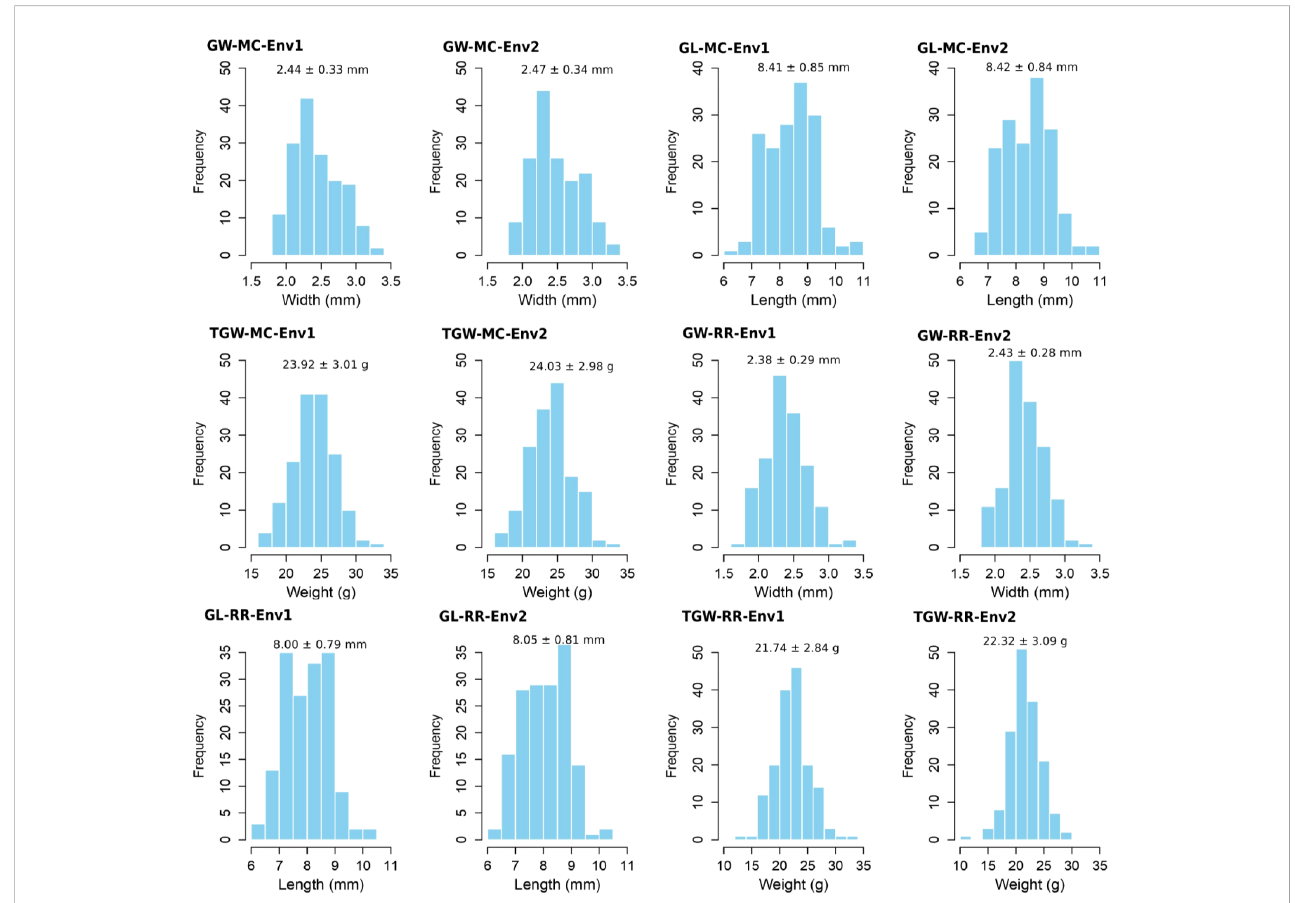
FIGURE 1 Phenotypic distributions for grain length (GL), grain width (GW), and thousand grain weight (TGW) of 159 accessions of main crop and ratoon rice in two